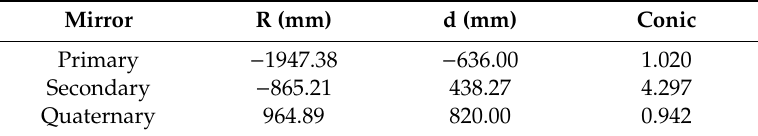
Table 6. Configuration parameters of the optimized o ff -axis four-mirror system.